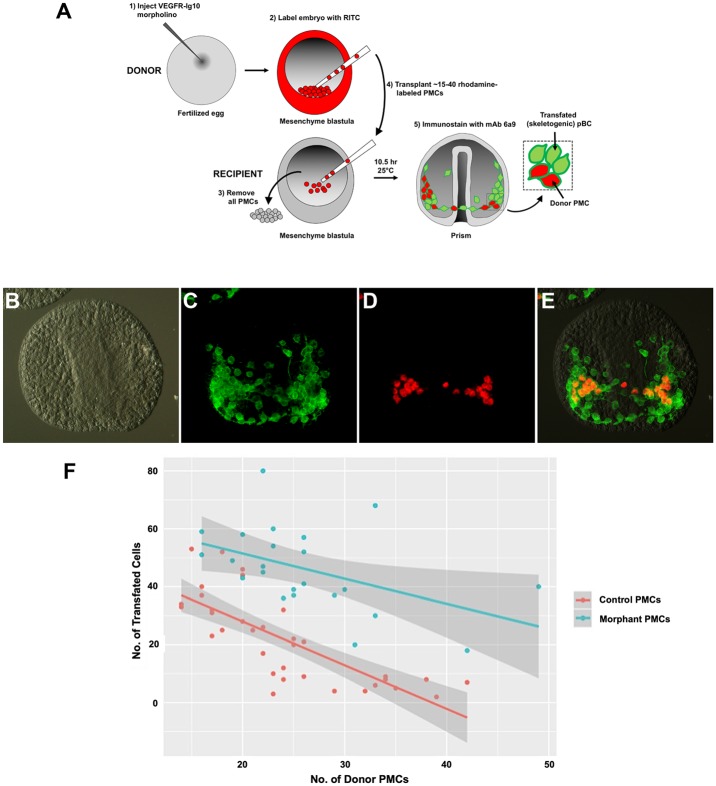
Knockdown of Lv-VEGFR-10-Ig in PMCs reduces their ability to suppress BC transfating.(A) Experimental design. The entire complement of PMCs was removed from a recipient embryo and replaced with 15–40 RITC-labeled PMCs from control or Lv-VEGFR-10-Ig morphant donor embryos. Then, 10.5 hours after transplantation, recipient embryos were fixed and immunostained with mAb 6a9 and a DyLight 488 goat anti-mouse secondary antibody. Donor PMCs were identified by (red + green) fluorescence, whereas transfated BCs exhibited only green fluorescence. (B-E) A representative embryo after immunostaining, viewed with DIC (B) or epifluorescence optics. (C) mAb 6a9 immunostaining showing all skeletogenic cells (donor PMCs and transfated BCs). (D) Rhodamine fluorescence showing donor PMCs. (E) Overlay of the two fluorescent channels. Cells that are green but not red are transfated BCs. (F) Quantification of the numbers of transfated BCs following PMC transplantation. Control PMCs (orange) were more potent at suppressing BC transfating than PMCs that had reduced expression of Lv-VEGFR-10-Ig (teal). In both cases, the number of transfated cells was inversely related to the number of PMCs in the blastocoel. Each point represents a single recipient embryo. Lines of best fit are indicated, and 95% confidence intervals are shown in gray. Raw data can be found in S2 Data. BC, blastocoelar cell; DIC, differential interference contrast microscopy; Lv-VEGFR-10-Ig, L. variegatus vascular endothelial growth factor receptor-10-Ig; mAb, monoclonal antibody; pBC, presumptive BC; PMC, primary mesenchyme cell; RITC, rhodamine isothiocyanate.